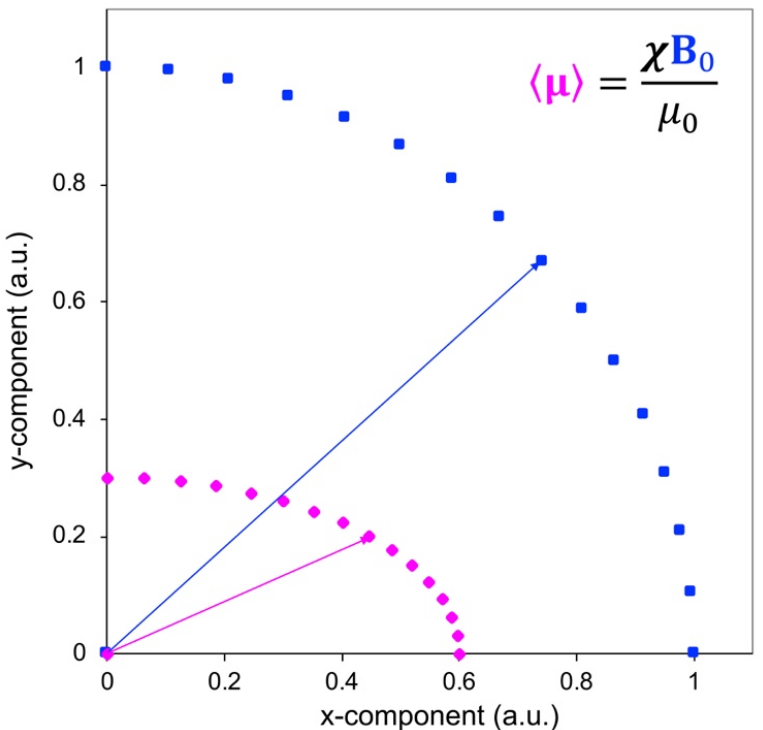
Figure 2. Pictorial visualization of the effect of an anisotropic magnetic susceptibility tensor on the average magnetic moment of the electron (magenta), based on the direction of the applied magnetic field (blue).